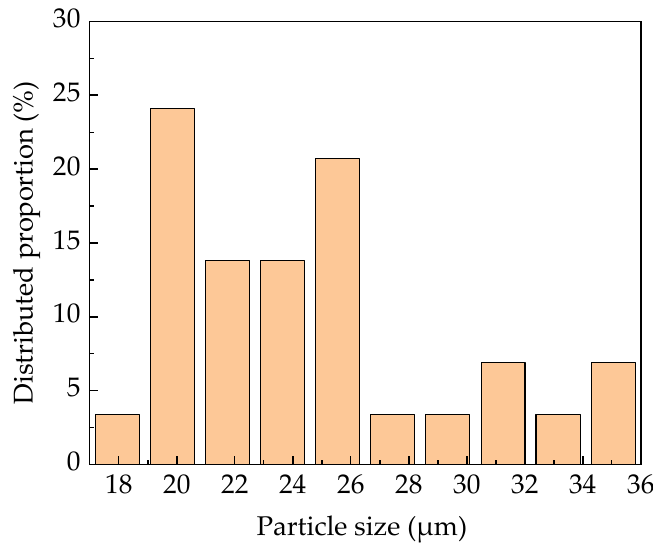
Figure 4. Typical particle size distribution of BC-m particles on fracture surface.